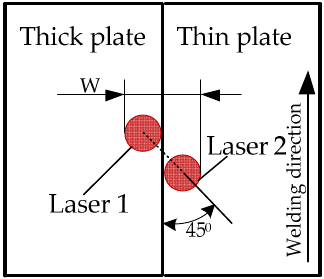
Figure 13. The arrangement mode III of dual-beam laser: one laser beam irradiates on the thick plate and the other laser beam on the thin plate. The line connecting the dual-beam laser focused spot centers inclines to the welding direction at an angle of 45°.